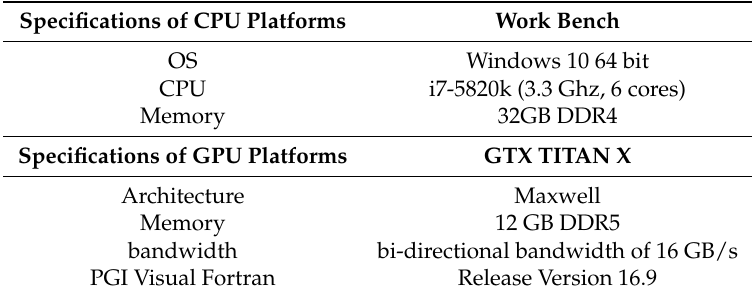
Table 1. Configurations of the computer. Graphics processing unit